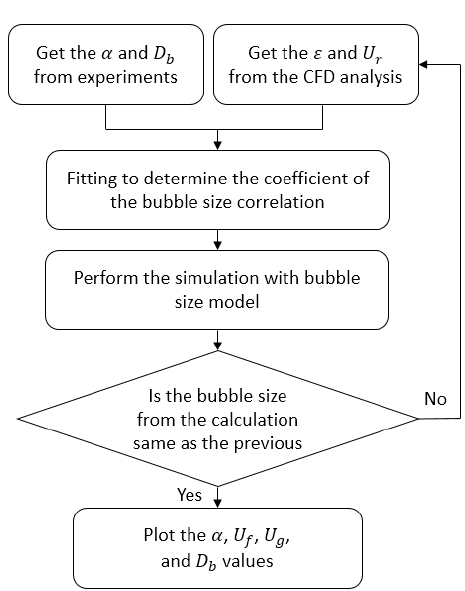
Figure 2. Iterative calculation procedure for the development of the bubble size model.